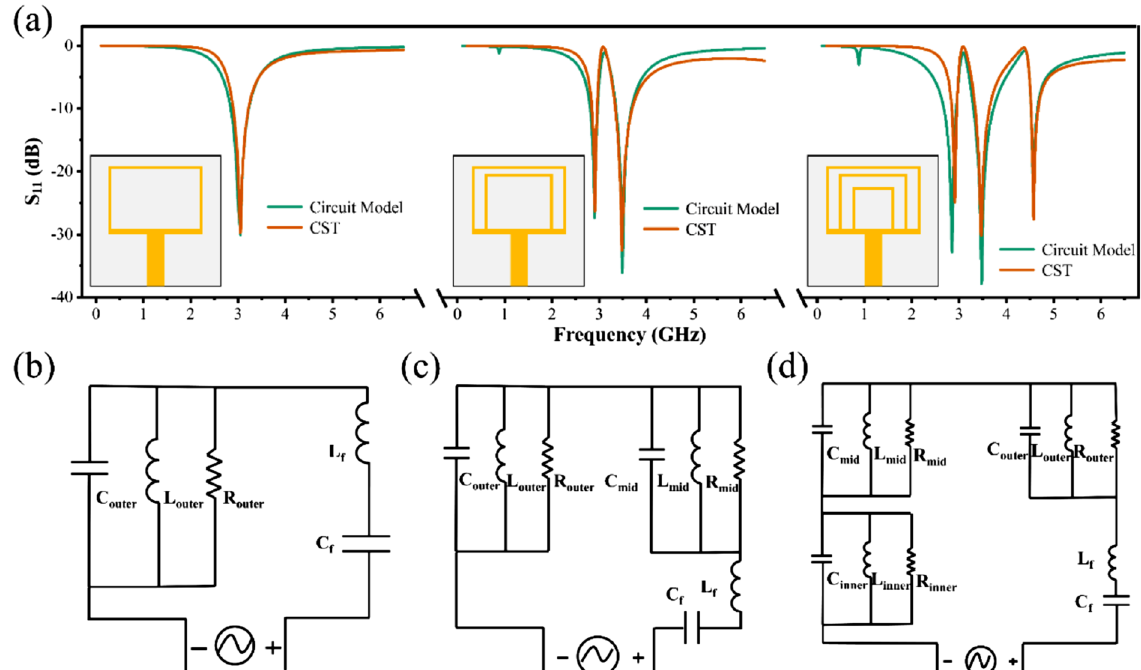
Figure 2. ( a ) Optimization process of triple ring antenna. Equivalent circuit model of ( b ) single ring antenna, ( c ) double ring antenna, and ( d ) triple ring antenna.